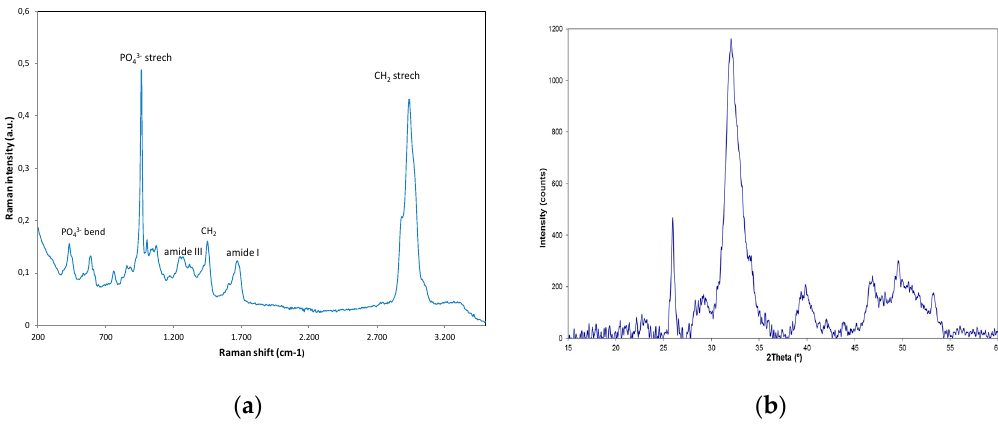
Figure 4. Raman spectrum ( a ) and XRD pattern ( b ) of crude bioapatites extracted from the central skeleton of blue shark ( P. glauca ).